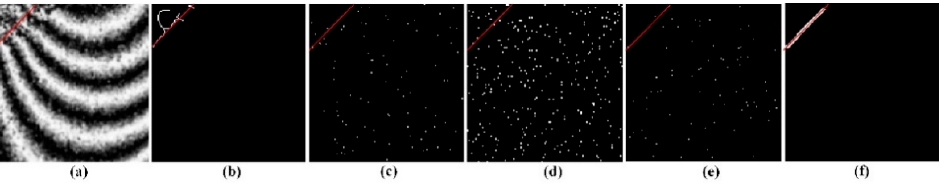
Figure 5. Results of an experimental fringe pattern from phase-shifting electronic speckle pattern shearing interferometer: ( a ) fringe pattern [19]; ( b ) OC result; ( c ) DVCM result; ( d ) PLDV result; ( e ) RM result; ( f ) LSOE result.